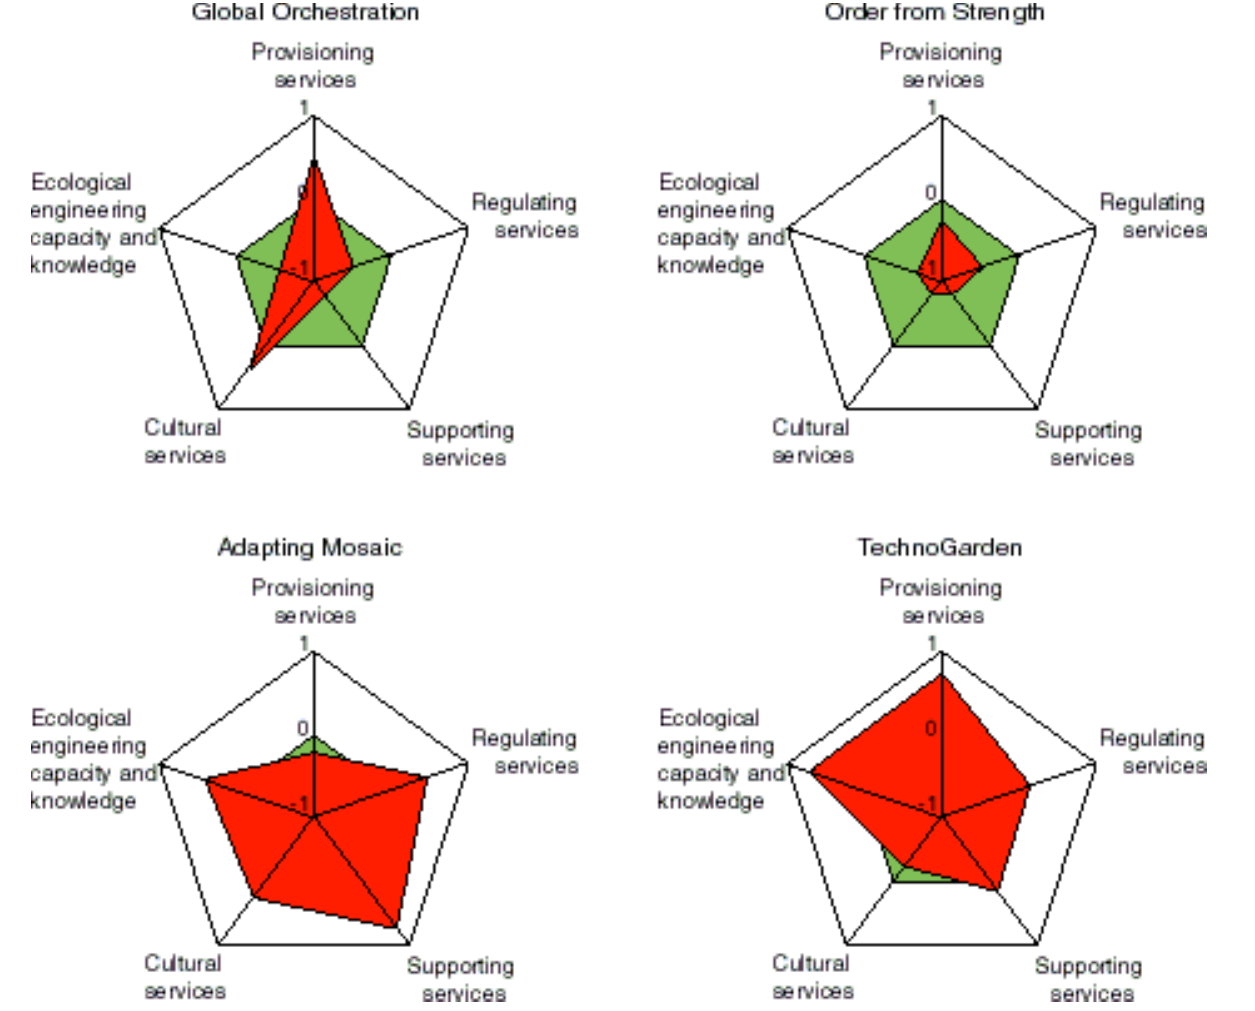
Fig. 4. Relative change in provision of ecosystem services (ES) in the four scenarios. Red polygons (“stars”) indicate the state of each ES at the end of the scenario storyline relative to a starting point of zero (indicated by green stars). A positive value (between 0 and 1) indicates an increase in the supply of a particular ES. A negative value (between 0 and -1) indicates a decrease in supply. Therefore, as the red stars are bigger, the overall supply of ES increases, but as they decrease, the overall supply of ES decreases (Excerpted from Millennium Ecosystem Assessment. 2005. Ecosystems and Human Well-Being: Scenarios,